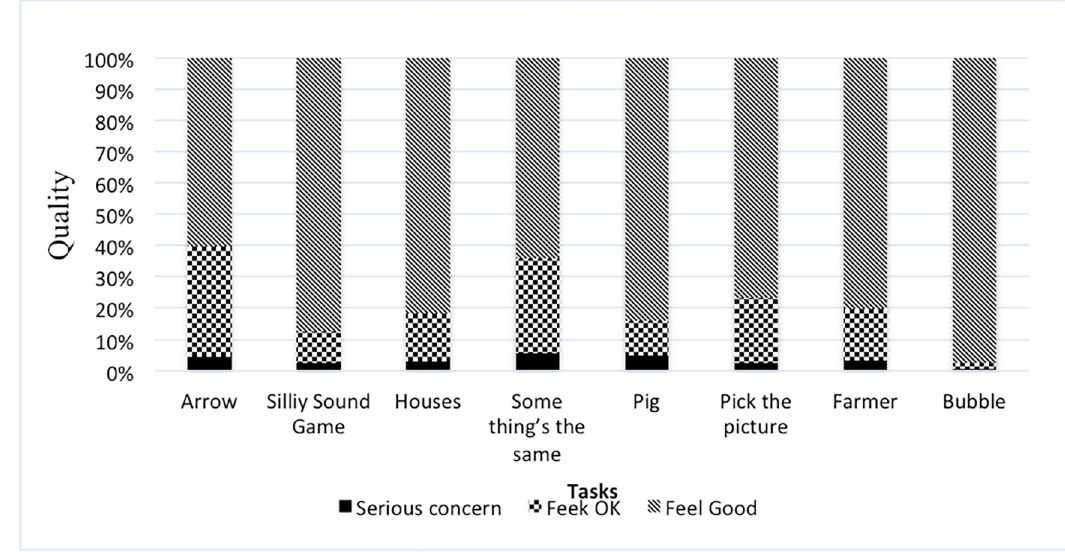
Fig 1. Executive Function task quality ratings ( N = 120).